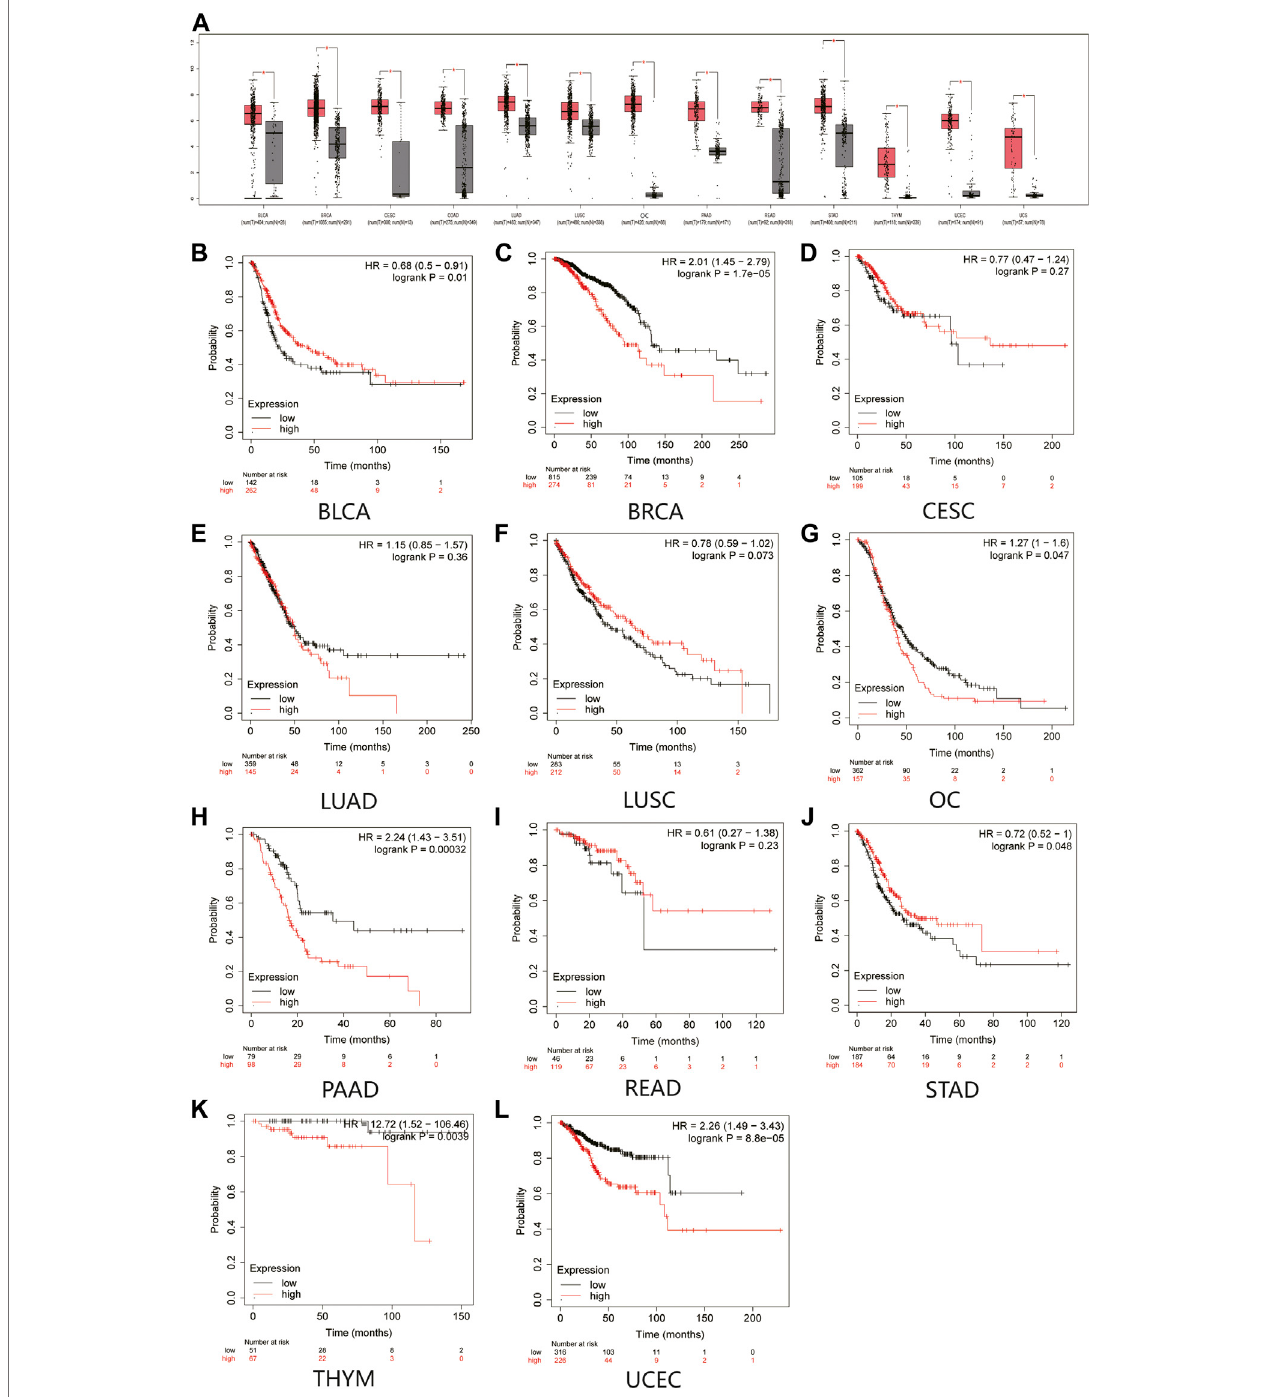
FIGURE 1 | Expression analysis and the overall survival (OS) analysis for MAL2 in multiple cancer. (A) MAL2 expression in 13 types of human cancer from GEPIA dataset. (B – L) Kaplan – Meier analysis of the overall survival of MAL2 in BLCA (B) , BRCA (C) , CESC (D) , LUAD (E) , LUSC (F) , OC (G) , PAAD (H) , READ (I) , STAD (J) , THYM (K) , and UCEC (L) . * p < 0.05. MAL2, T-cell differentiation protein 2; GEPIA, Gene Expression Pro fi ling Interactive Analysis; BLCA, bladder urothelial carcinoma; BRCA, invasive breast carcinoma; CESC, cervical squamous cell carcinoma; LUAD, lung adenocarcinoma; LUSC, lung squamous cell carcinoma; OC, ovarian cancer; PAAD, pancreatic adenocarcinoma; READ, rectal adenocarcinoma; STAD, stomach adenocarcinoma; THYM, thymoma (THYM); UCEC, uterine corpus endometrial carcinoma.